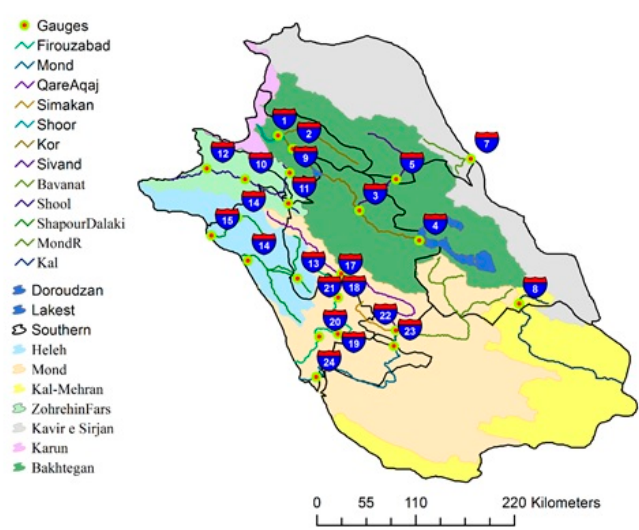
Figure A3. Layout of main basins, rivers, and location of gauging stations in Fars province.